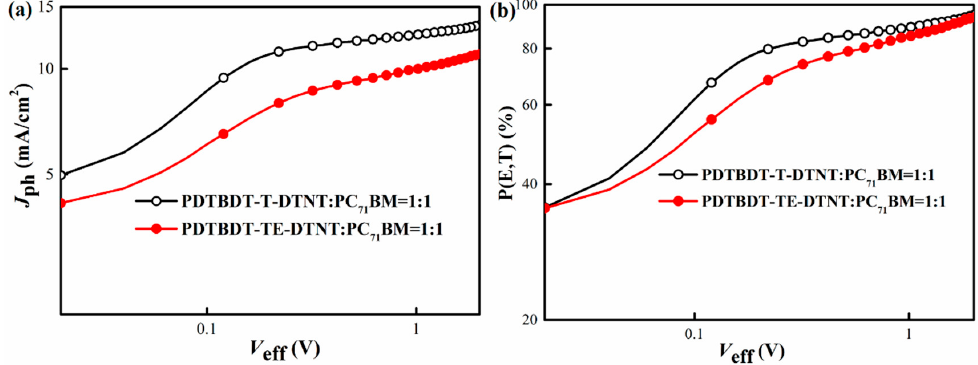
Figure 7. Photocurrent versus effective voltage for the copolymer/PC 71 BM-based i-PVC devices.